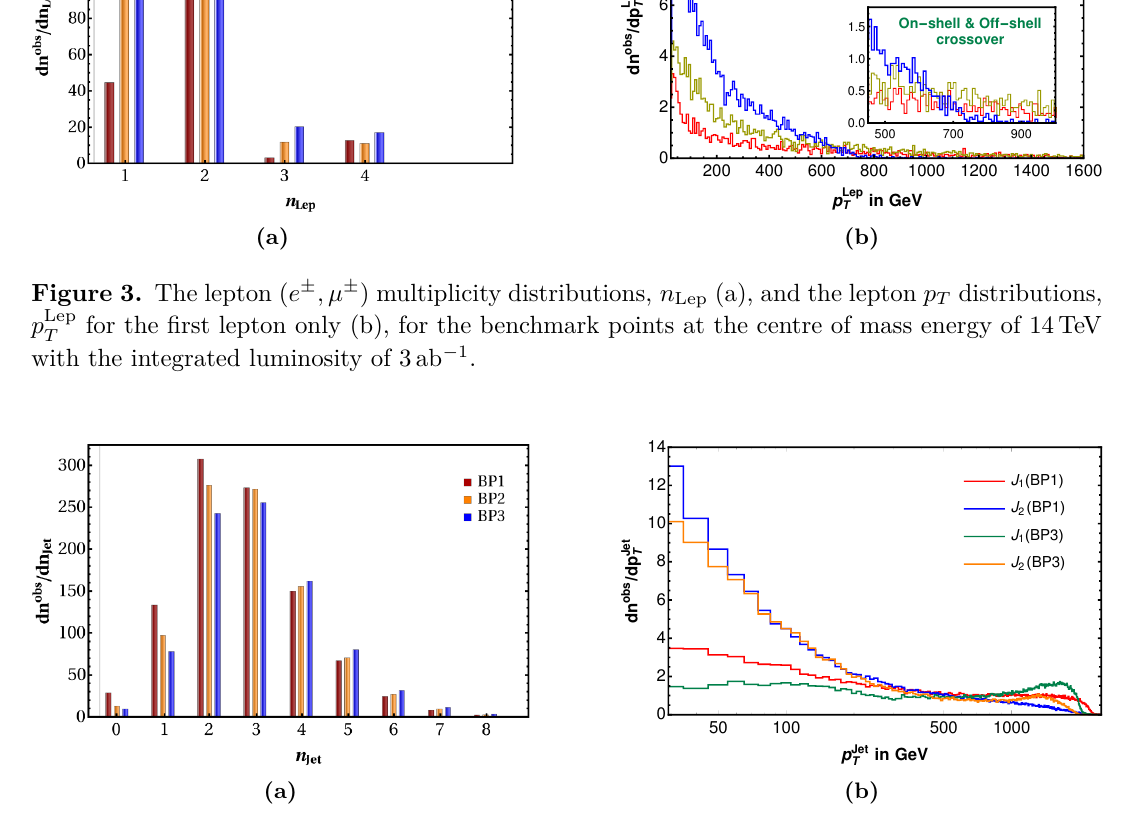
Figure 4. The Jet multiplicity distribution ( n jet ) for three benchmark points (a), and the p T distribution ( p jet ) of the 1 st and 2 nd Jets with BP1 and BP3 (b) are shown at the centre of mass T energy of 14 TeV with the integrated luminosity of 3 ab − 1